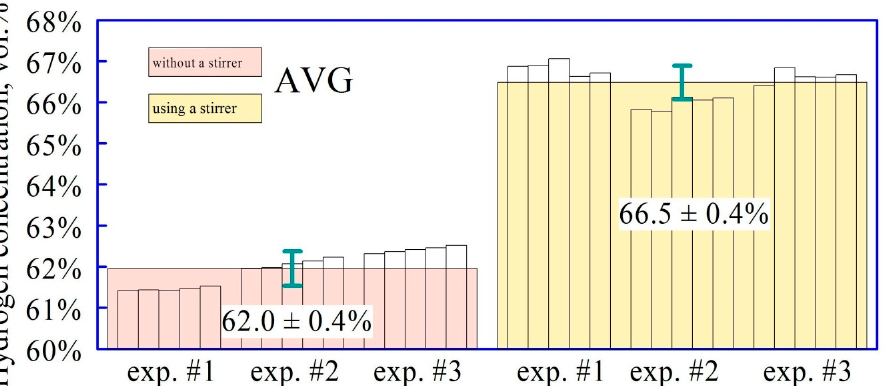
Figure 7. Pyrolysis hydrogen concentration during the fourth hour of reaction for reactor without stirrer (left) and reactor with a stirrer (right) in a catalytic propane pyrolysis study. The error bars represent ±1 σ of the average.